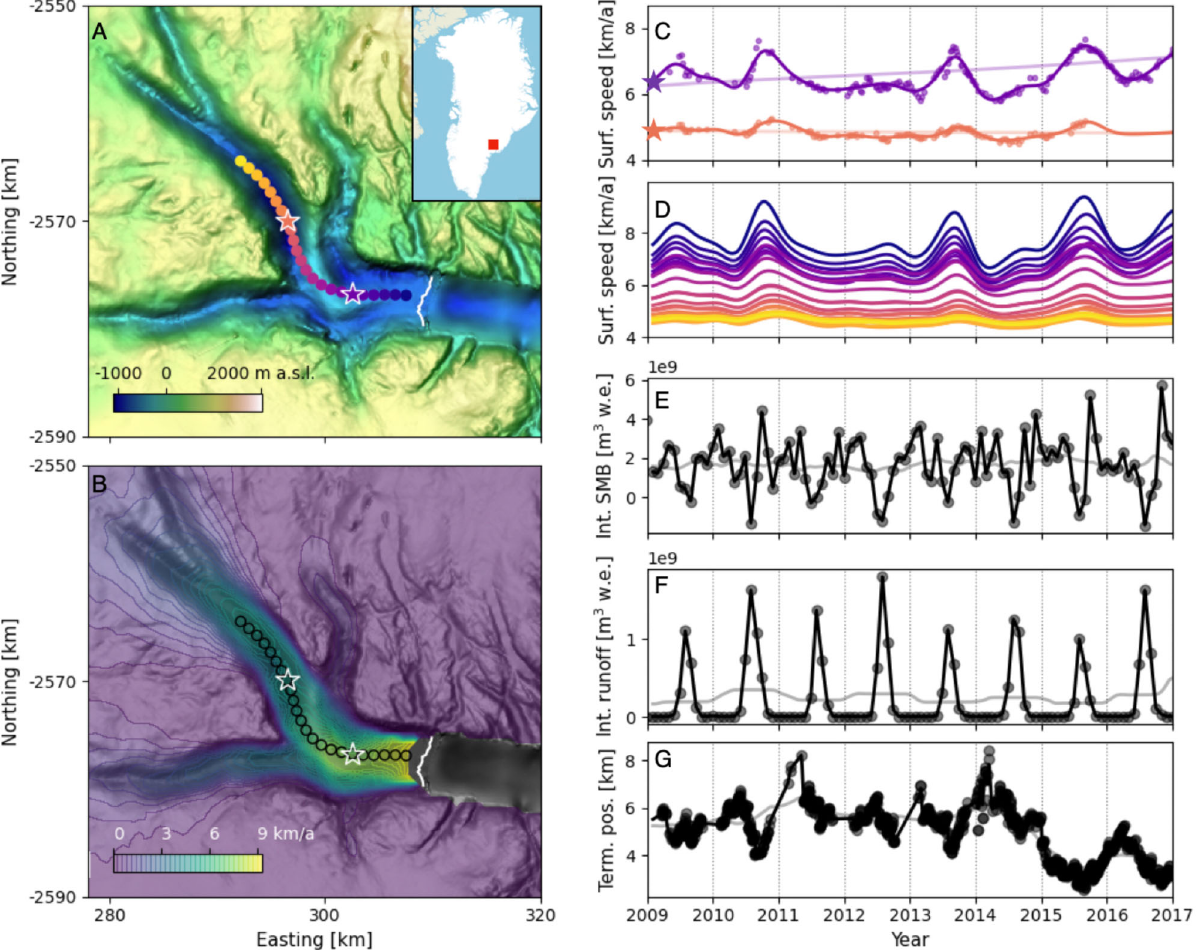
Fig. 1 | The physicalsetting ofHelheim Glacierstudiedhere.A Hillshade mapof HelheimGlaciersubglacialtopographyfromMorlighemetal. 96 with2009terminal edge from Joughin et al. 38 in white, points along central fl owline in bright colors, and inset map of Helheim Glacier location within Greenland; B Mean ice surface speed as of 2016 97 , with fl owline points outlined; C Ice surface speed at two loca- tions (starred on panels A , B ) from Joughin et al. 38 (points) and B-spline smooth approximation to each time series (curves); D B-spline continuous velocity func- tionsforeachpointalongthe fl owlineinpanel A ,withcurvecolorindicatingwhich